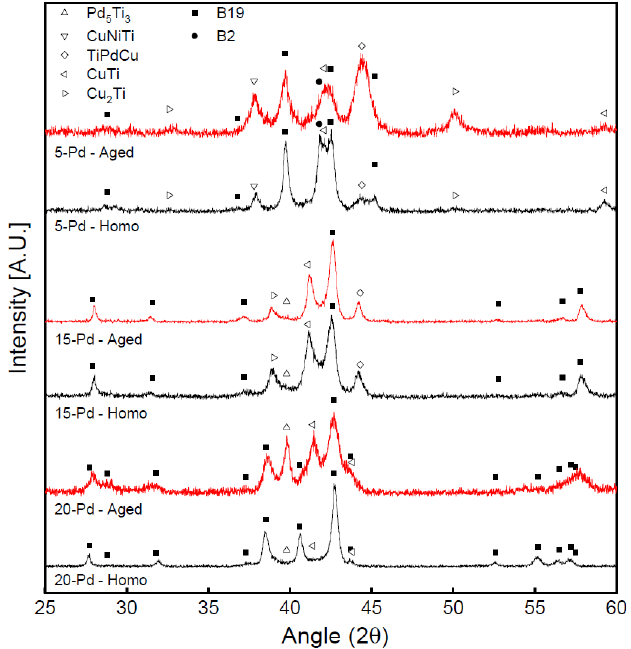
Figure 6. XRD spectra of group B Ni-Ti-Cu-Pd alloys after the homogenization (900 °C × 24 h) and aging (550 °C × 3 h) treatments. Matrix phases are represented by plain symbols and tetragonal precipitates by open ones.